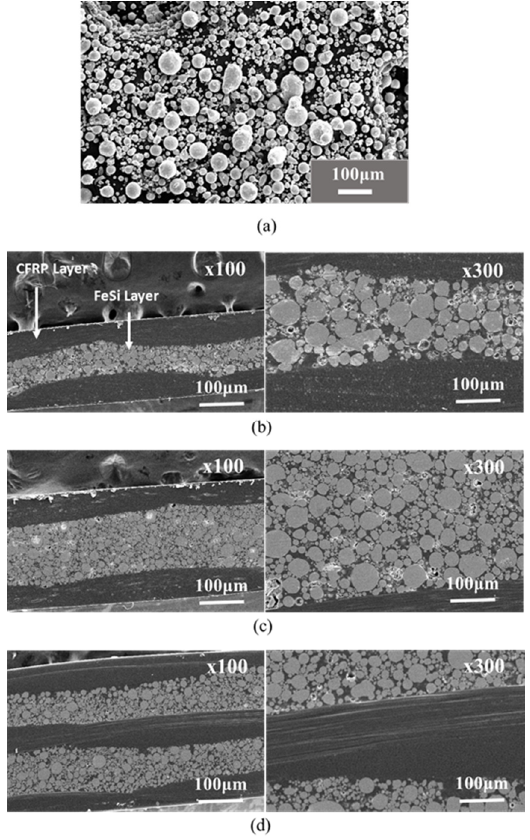
Figure 2. Typical SEM image of CFRP-FeSi composites: ( a ) as-received FeSi powders; ( b ) CF-FeSi-1; ( c ) CF-FeSi-2 and ( d ) CF-FeSi-3.